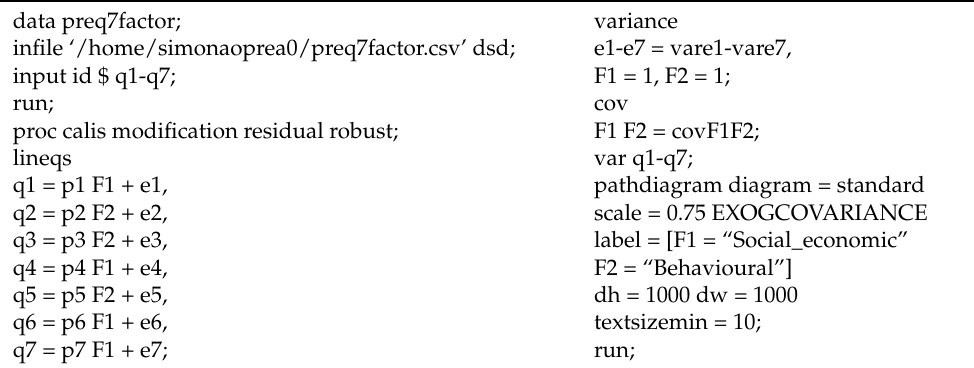
Table 1. CALIS implementation of the first-order CFA model for the pre-trial questionnaire. data preq7factor;